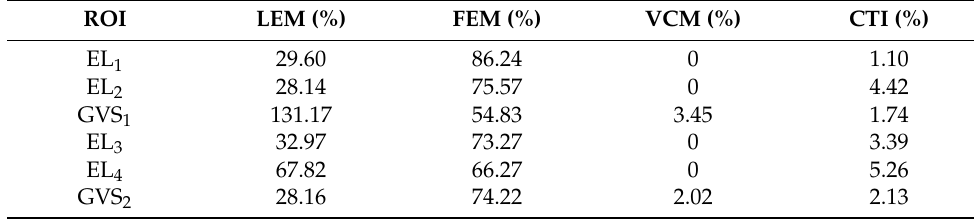
Table 3. Errors of the reconstructed conductivity values σ L = σ l + σ t 1 + σ t 2 values measured by the impedance analyzer at 10 Hz. Note that the reference values were themselves used in the VCM method for the compartments of EL 1 , EL 2 , EL 3 , and EL 4